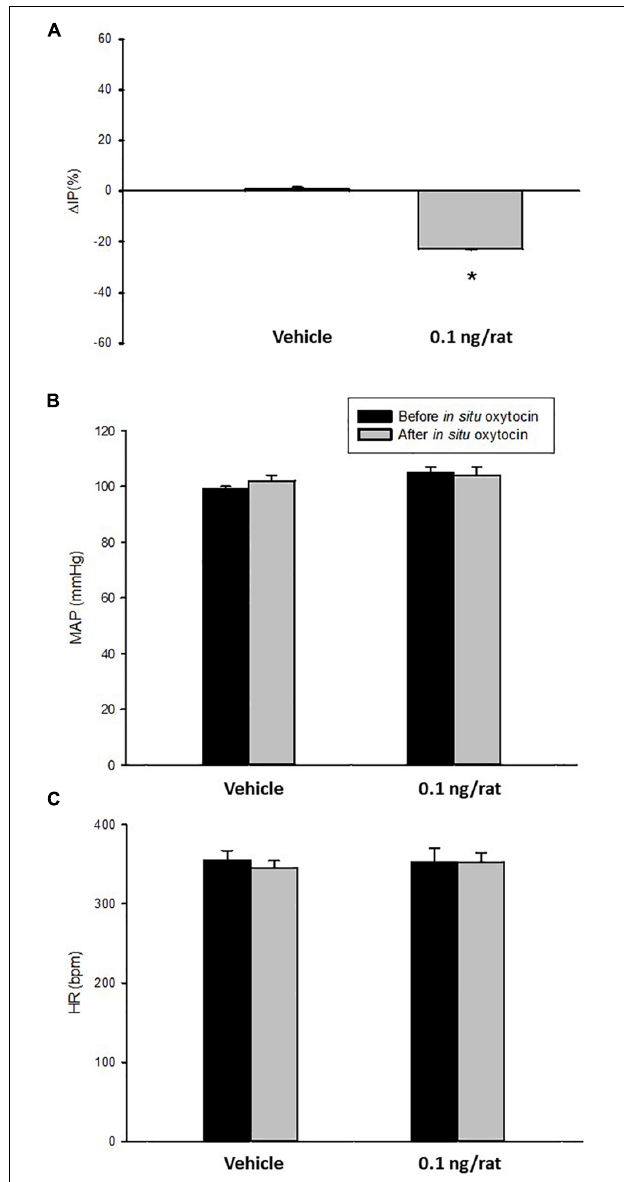
FIGURE 4 | Percent change in intravesical pressure ( A ,% (cid:49) IP) after in situ administration of 0.1 mL of saline (vehicle) or oxytocin (0.1 ng/rat) in sham animals ( N = 7). Mean arterial pressure ( B , MAP, mmHg) and heart rate ( C , HR, bpm) at baseline and after in situ administration of 0.1 mL of saline (vehicle) or oxytocin dose (0.1 ng/rat) in sham animals, * p < 0.05 vs. saline ( N =